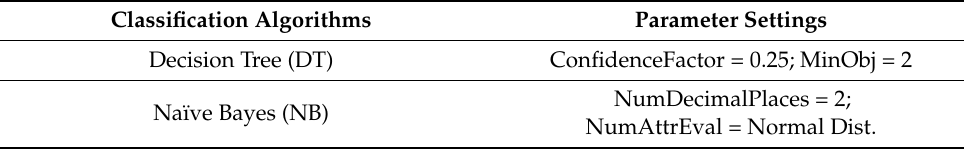
Table 1. Classification